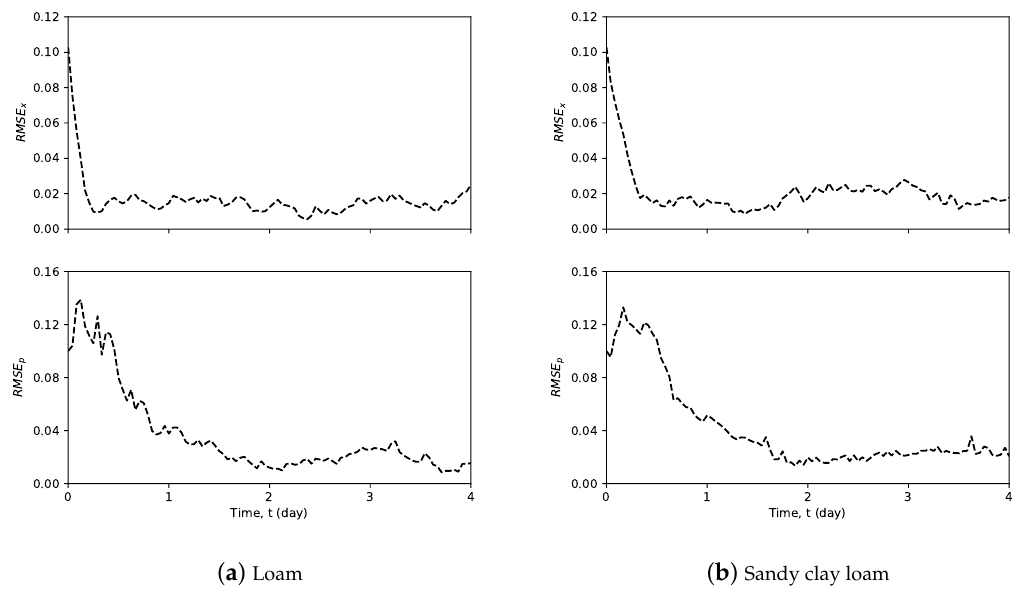
Figure 9. Trajectories of RMSE measuring the estimation performance of DeMHE for studying impact of inputs (Scenario